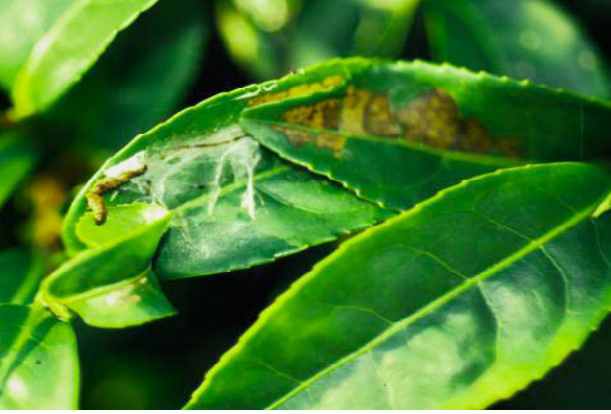
Figure 1. Rolled leaves, referred to as nests of A. honmai larvae. In the nest the larva damages the leaf. In this picture a cadaver is located outside its